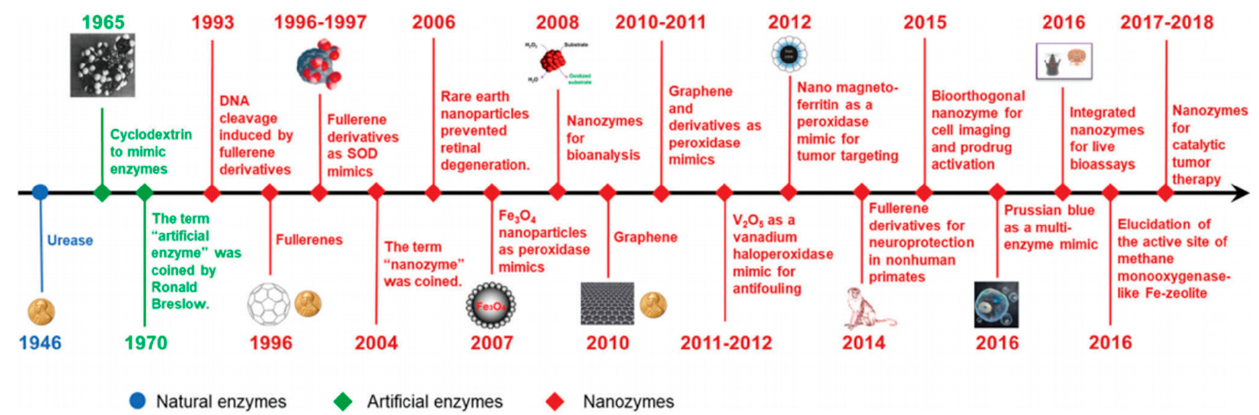
Figure 1. Timeline highlighting relevant historical benchmarks of nanozyme development. (Reproduced with permission [9], Copyright 2019, The Royal Society of Chemistry).